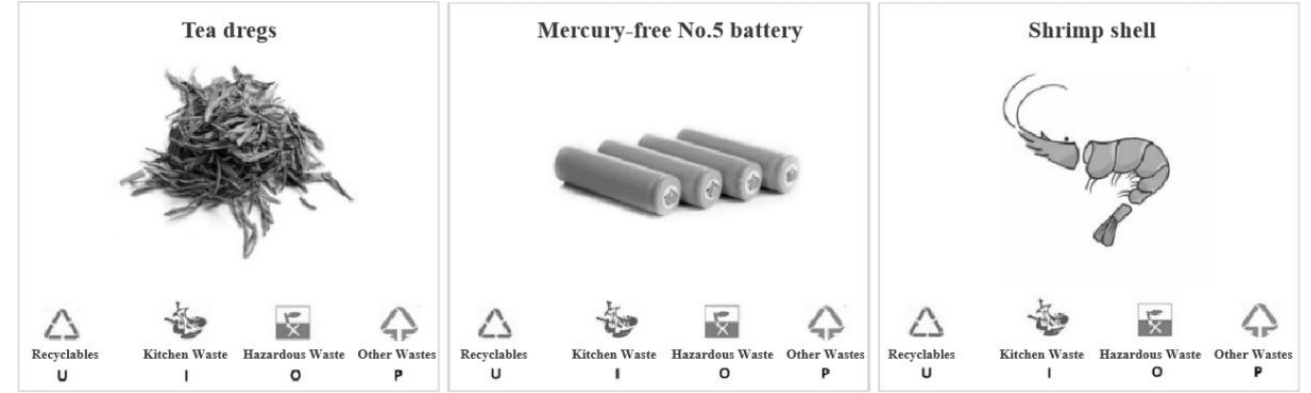
Figure 2. Examples of stimulus materials (Stimulus material is presented in figures, upper part is the garbage name, middle part is the garbage example, lower part is the options of garbage categories. Keystrokes of U/I/O/P).